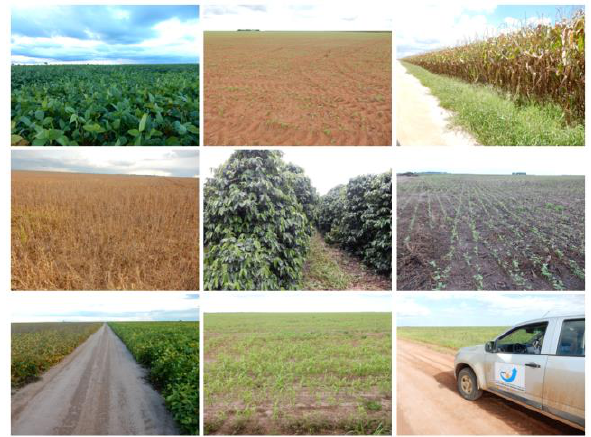
Figure 3. Photographs taken during the second field campaign in LEM municipality (14-19th March